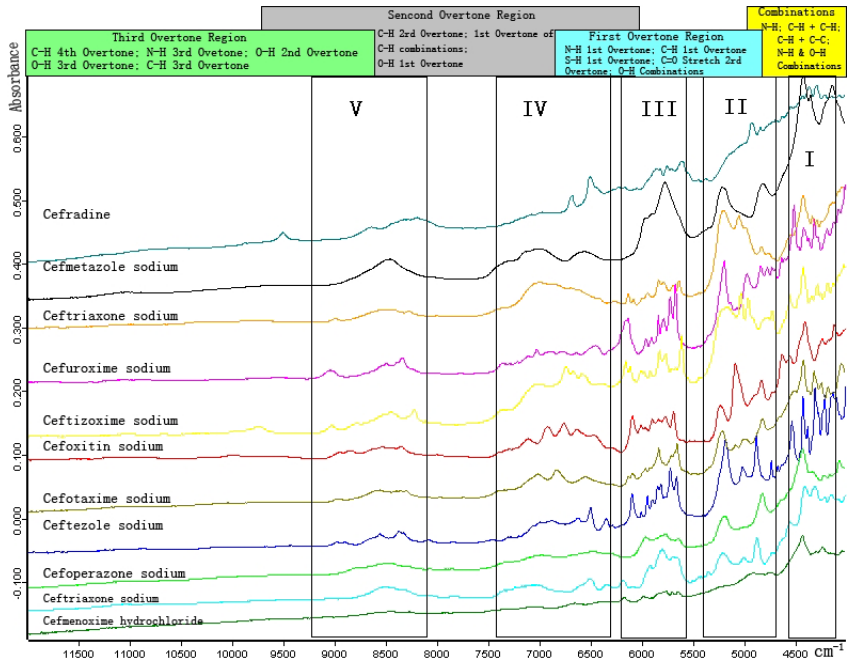
Table 2. Characteristics of the initial published calibration models for cephalosporins.